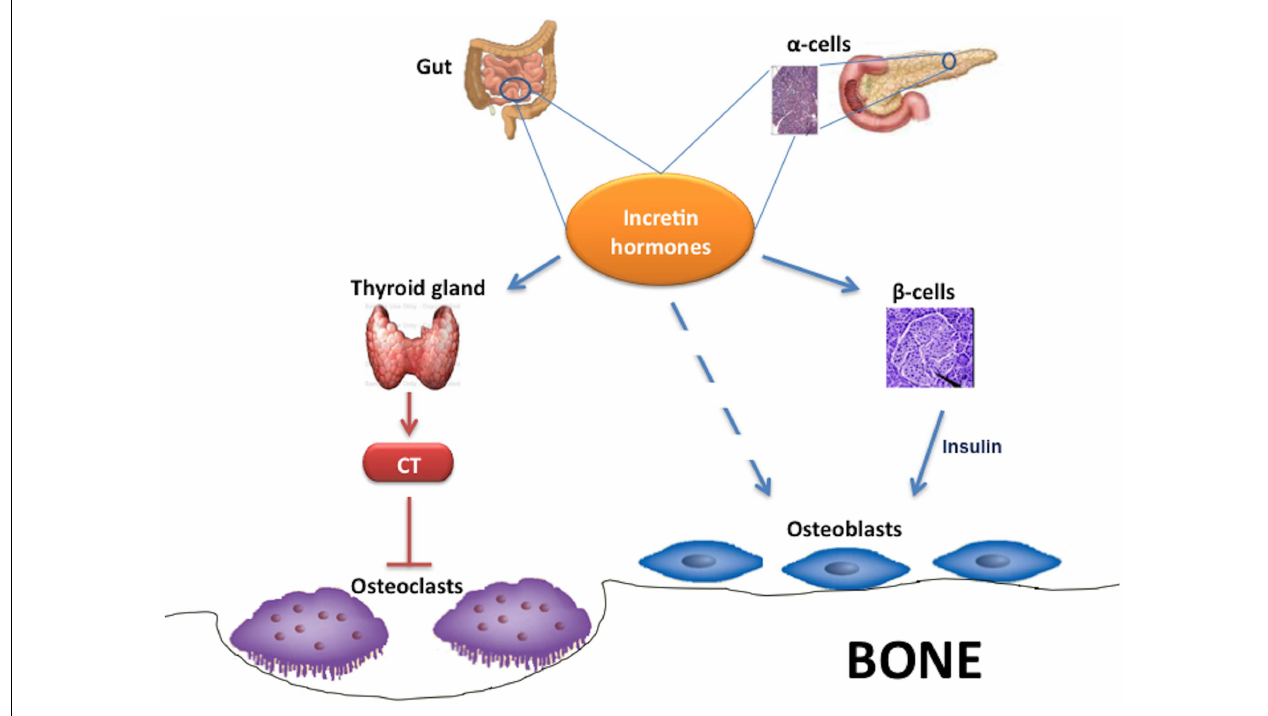
indirectly via increased insulin secretion as well as through a direct action on osteoblasts. Moreover, incretin hormones can inhibit osteoclastogenesis by stimulating calcitonin production. CT,